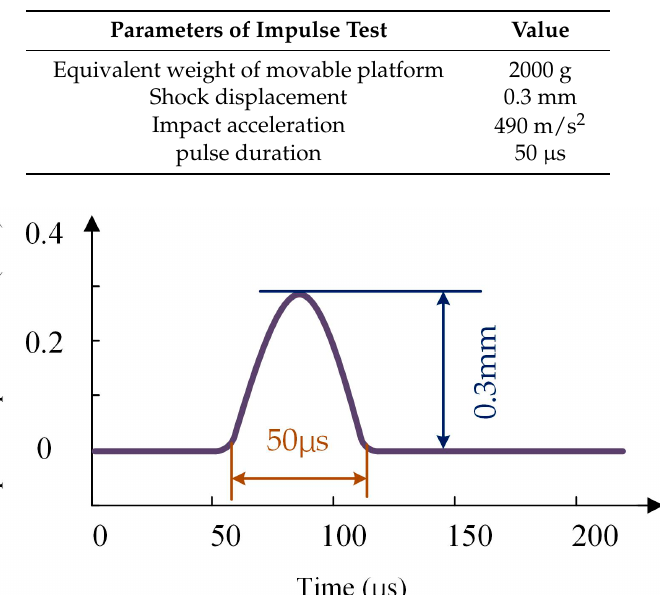
Table 4. Specification of external disturbance.